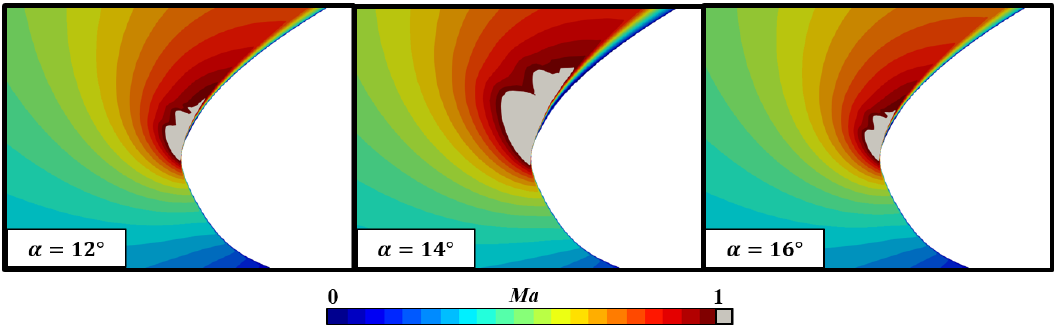
Figure 5. A supersonic pocket near the leading edge at three selected